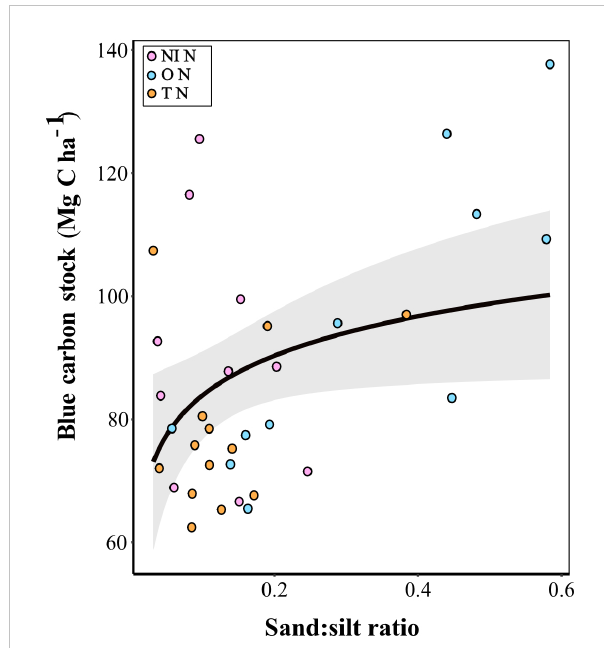
FIGURE 4 Carbon stock against Sand:silt ratio for natural (N) sites at Northey Island (NI; pink), Orplands (O; blue), and Tollesbury (T; orange) with a logarithmic curved line and 95% con fi dence interval (grey bar). The higher the sand:silt ratio, the greater the proportion of sand particles in the predominantly silty